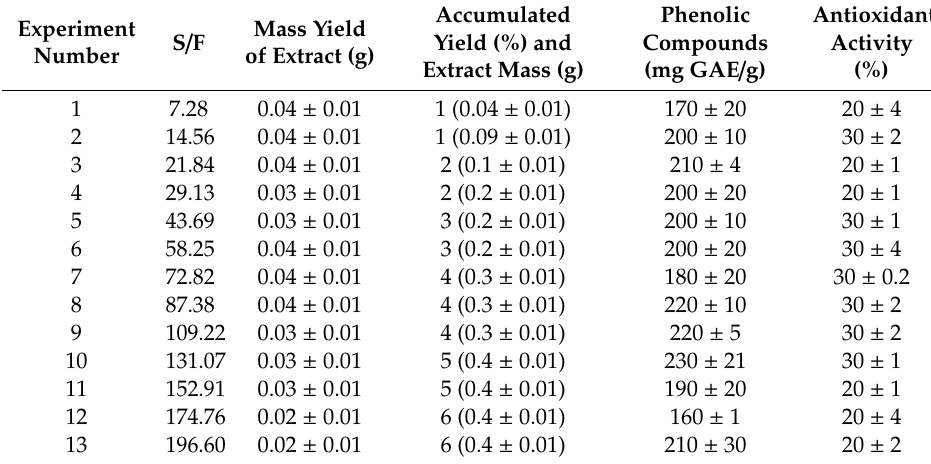
Table 1. Determination of pilot extraction kinetics for red propolis using supercritical fluid extraction by CO 2 with the results for S / F; mass yield of extract ± standard deviation (SD); mass yield of accumulated extract ± SD; total phenolic compounds in mg / GAE / g ± SD; and antioxidant activity (%) / ± SD (parameters: 7.5 g of sample; 40 ◦ C; 100 bar; CO 2 flow rate 6.0 g